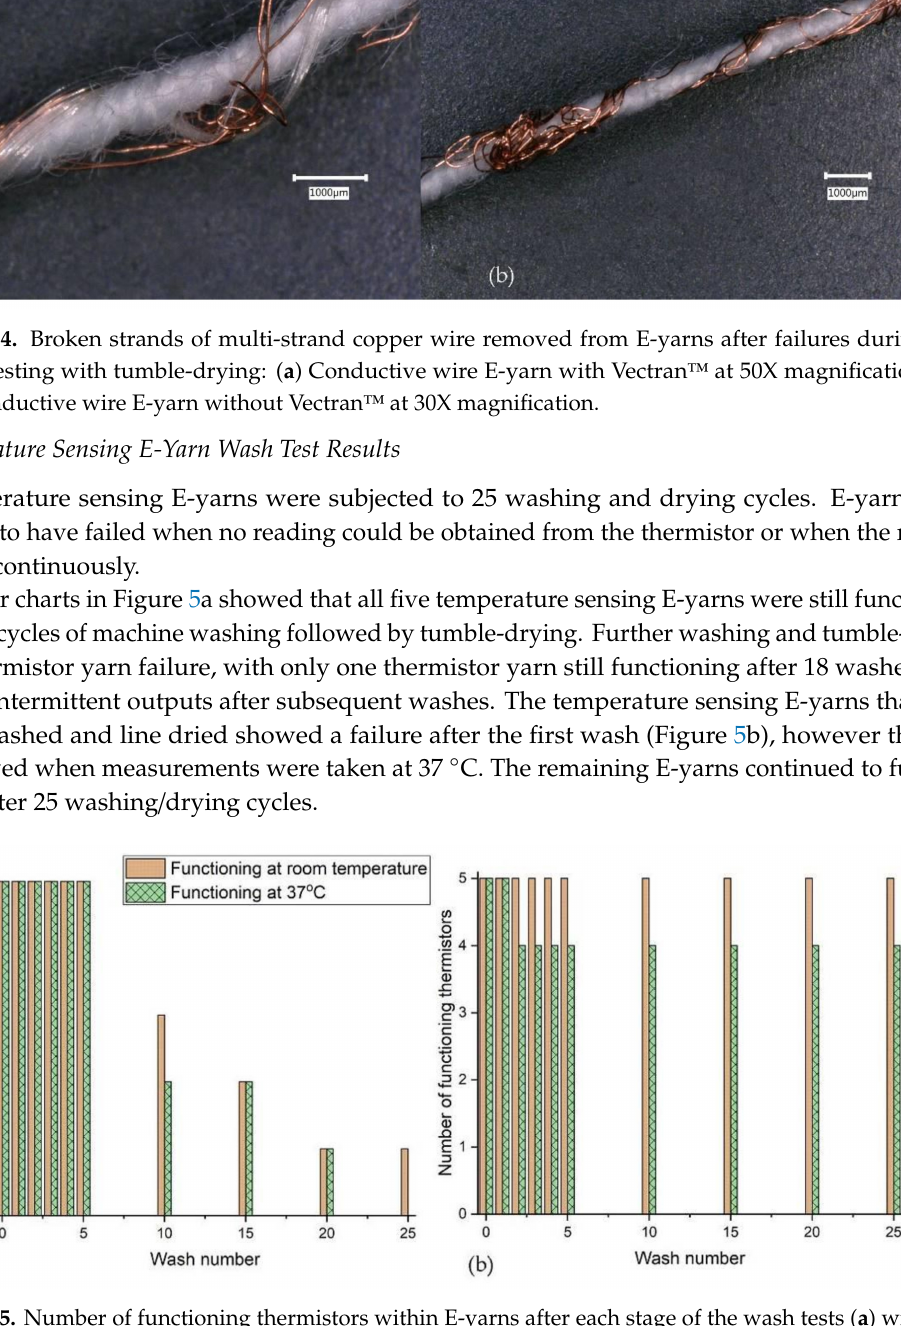
Figure 5. Number of functioning thermistors within E-yarns after each stage of the wash tests ( a ) with tumble-drying; ( b ) with line